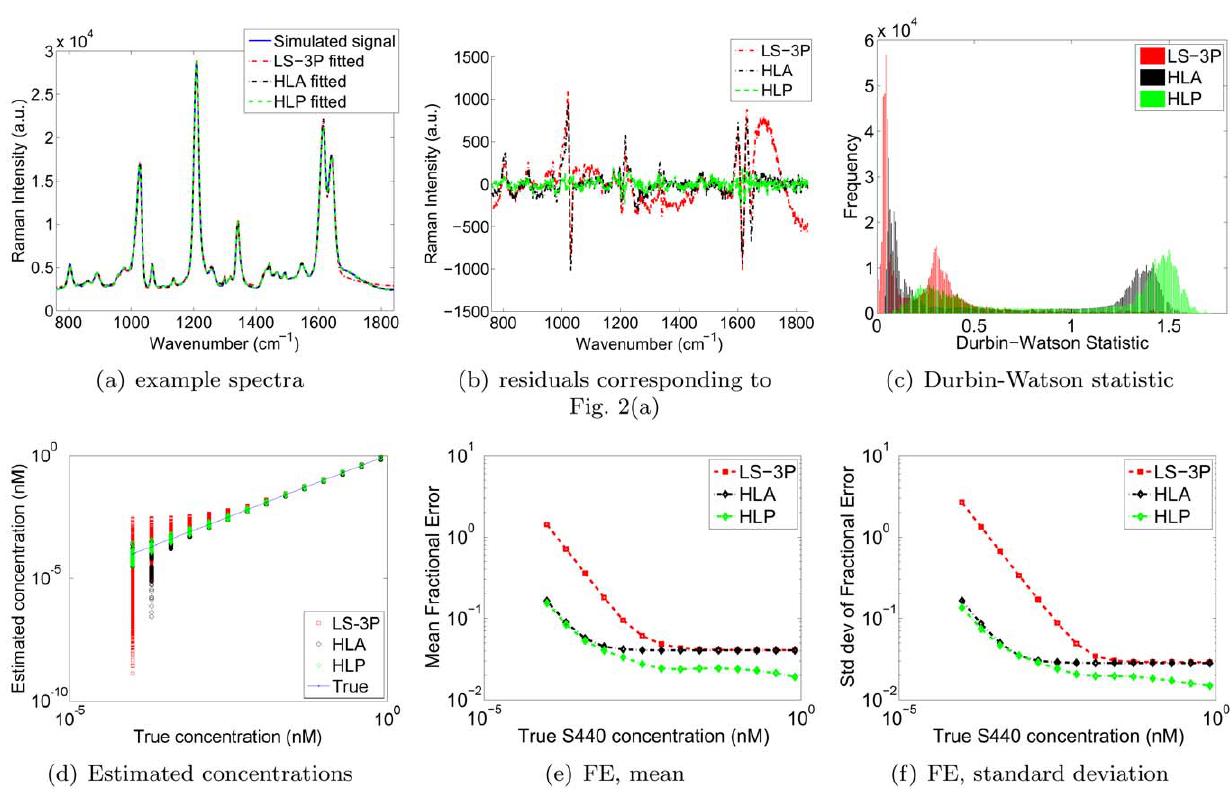
Figure 2 . Simulation results. (a) Example of fitted spectra, (b) corresponding residuals, (c) histograms of Durbin-Watson statistics produced by each method, (d) estimated concentrations, and (e-f) mean and standard deviation of fractional errors generated by the LS-3P, HLA and HLP algorithms.